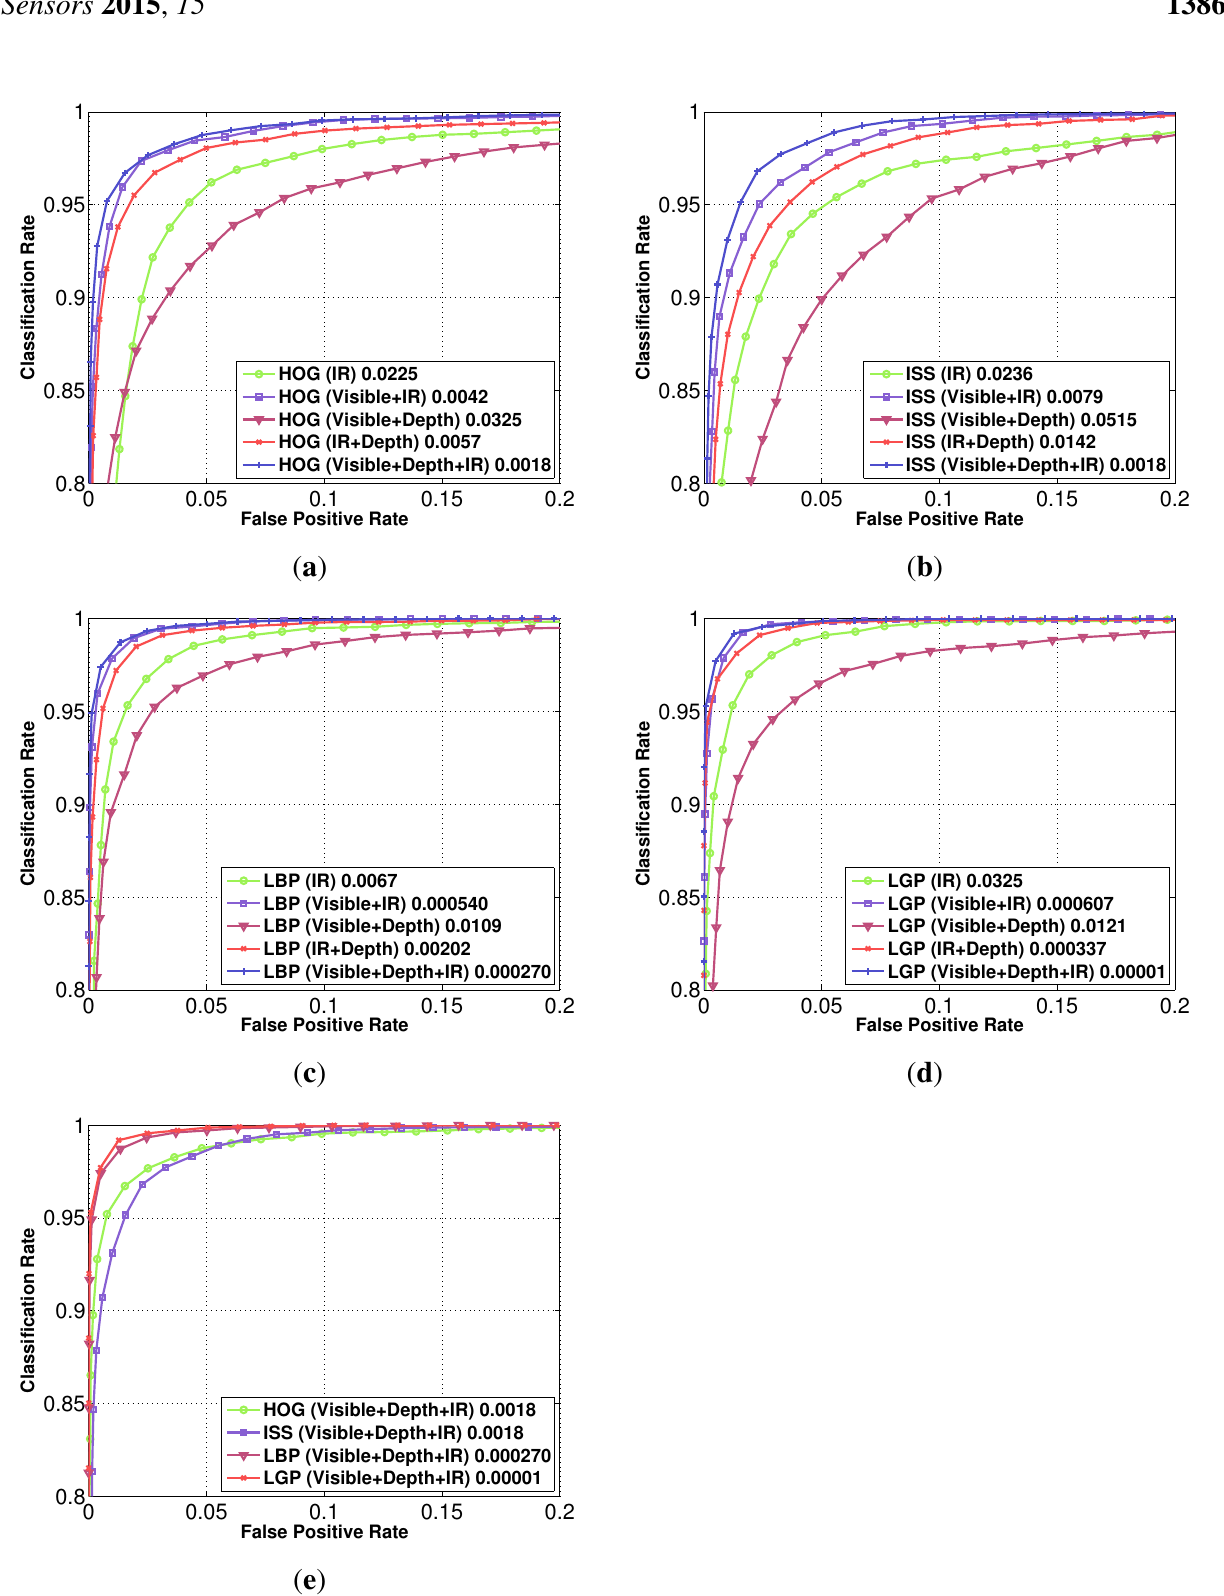
Figure 10. Classification performance comparison for each feature using different modality fusions (visible + IR; visible + depth; IR + depth; intensity + depth + IR) and the best single modality for each feature: ( a ) HOG; ( b ) ISS; ( c ) LBP; ( d ) LGP. In order to highlight differences between different features, in ( e ) is plotted, for comparison, all modality fusions for different